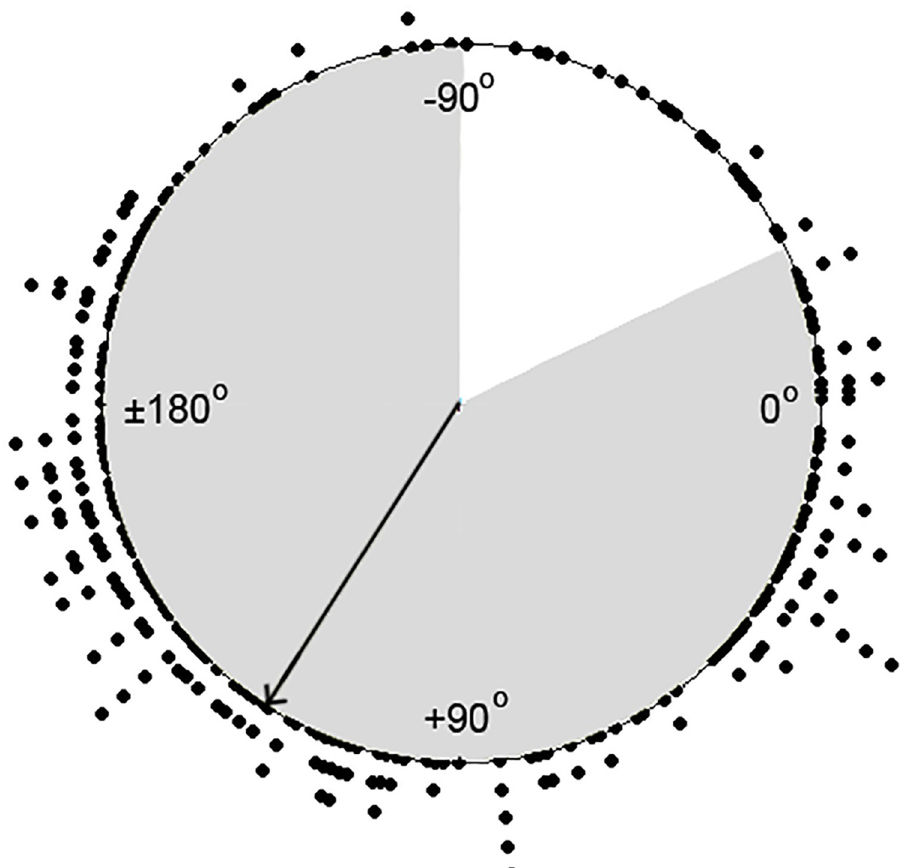
Fig 4. Distribution of the orientation of the electrical heart axis plotted in a circle diagram. Each dot represents one fetus. The arrow represents the mean electrical heart axis with corresponding 90% PI in the frontal plane in